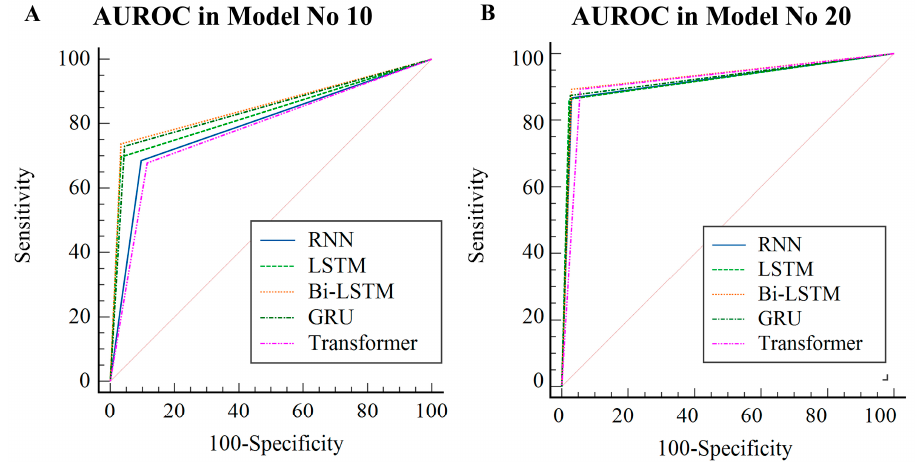
Figure 6. Differences in the AUROC of models 10 and 20 between the five different algorithms using the test dataset. ( A ) AUROC in Model No 10. ( B ) AUROC in Model No 10. RNN, recurrent neural network; LSTM, long short-term memory; GRU, gated recurrent unit; Bi-LSTM, bidirectional long short-term memory; AUROC, area under the receiver operating characteristic. Table 2. Pairwise comparison of AUROC of Model 10 between 5 algorithms using test